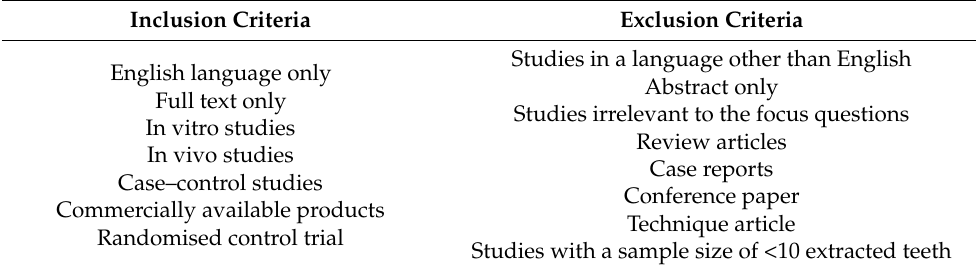
Table 2. Inclusion and exclusion